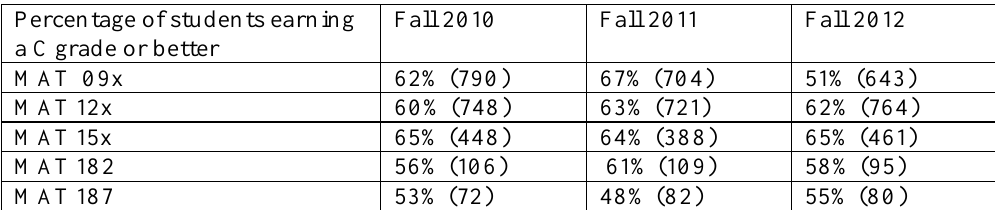
Aggregated Data Fall 2010 – Fall 2012: Overall Grades Percentage of students